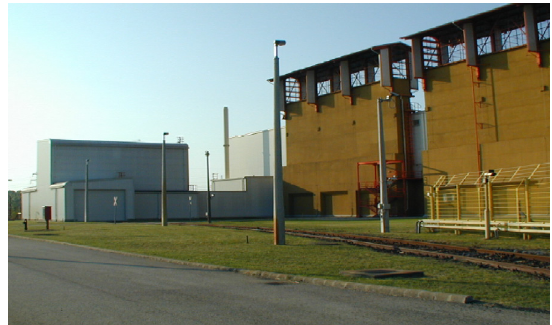
Fig. 2. Dry vault store [4].